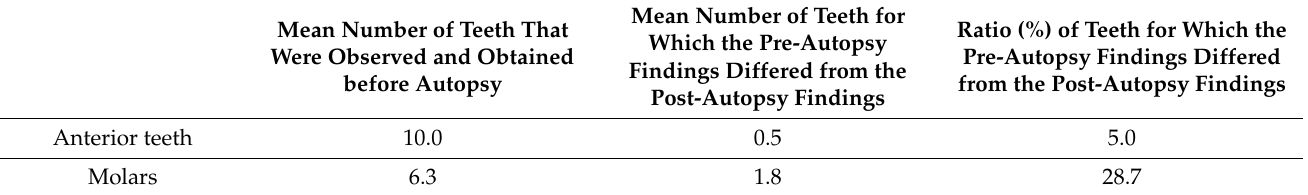
Table 2. The mean number and ratio of teeth for which the pre-autopsy findings were different from post-autopsy